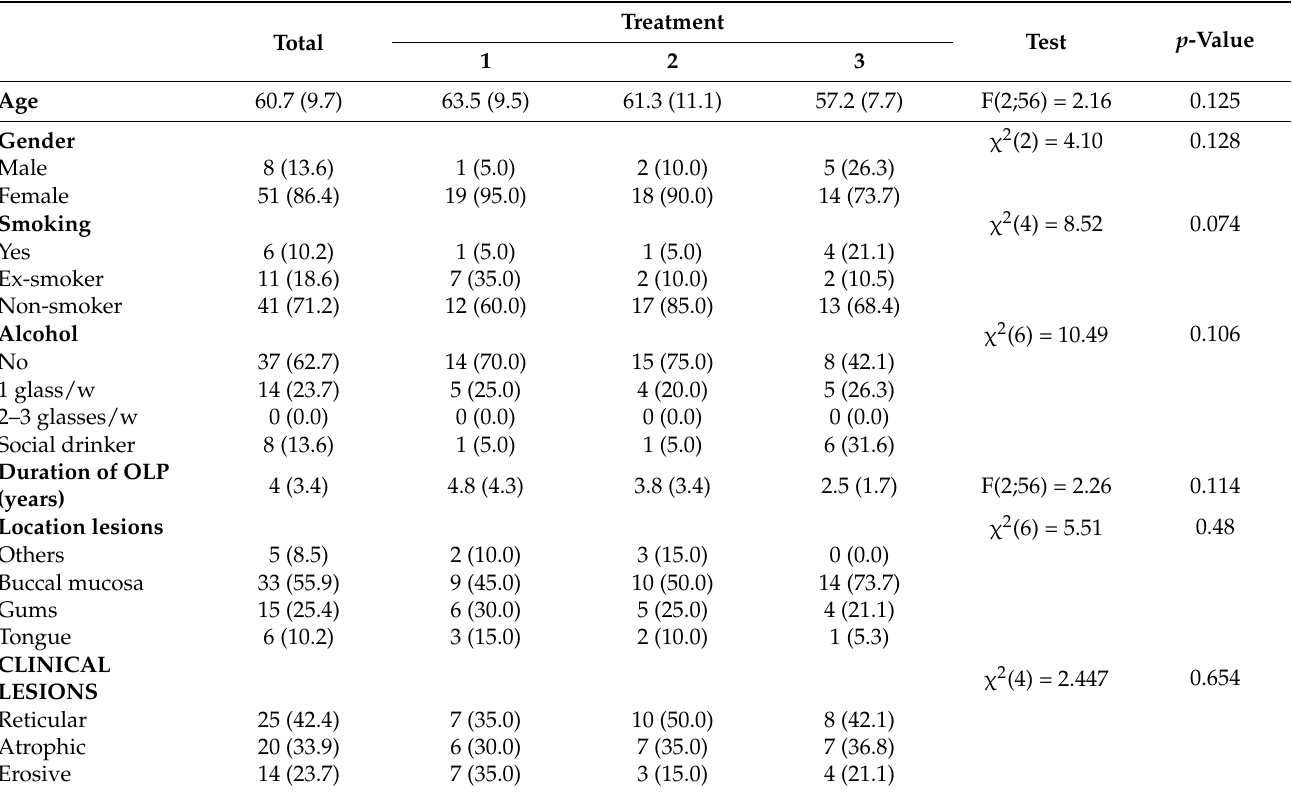
Table 1. Descriptive and comparative study of the variables between the different treatment groups. No statistically significant differences were observed between the groups for any of the variables.